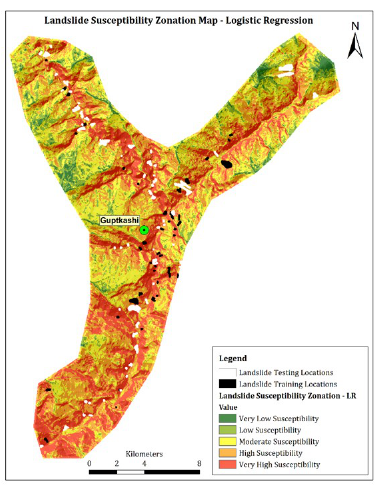
Figure 3. LSZ map obtained using weights from LR, without data balancing